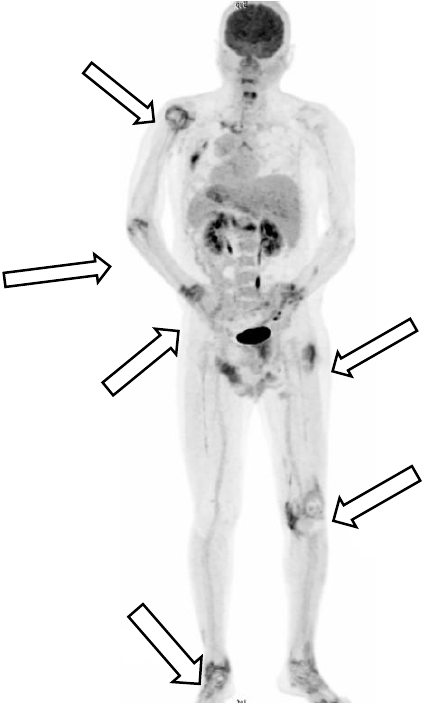
Figure 2. A gallium-67 tumor scan indicated inflammation over left shoulder, left sternoclavicular junction, left interscapular region, lateral right hip region, left buttock, right knee, and left ankle, but no evidence of malignancy.